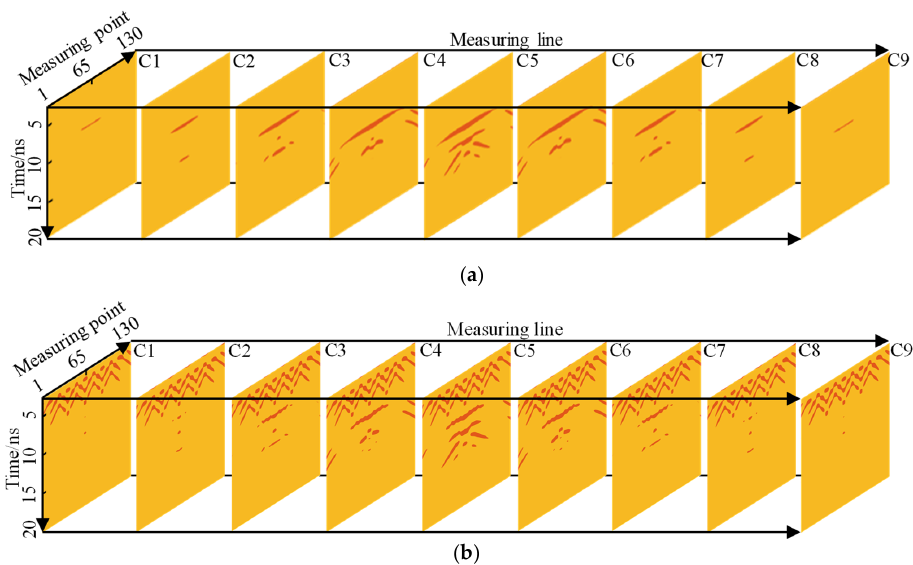
Figure 17. Slices along the measuring line: ( a ) Support A, ( b ) Support B. This figure illustrates that the void response increases as the measuring line approaches the center of the void.